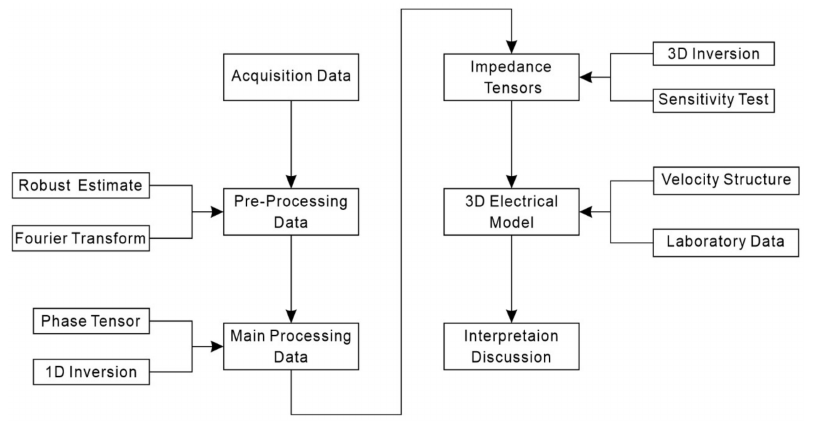
Figure 2. Flow diagram showing major parts of the standard processing steps for MT